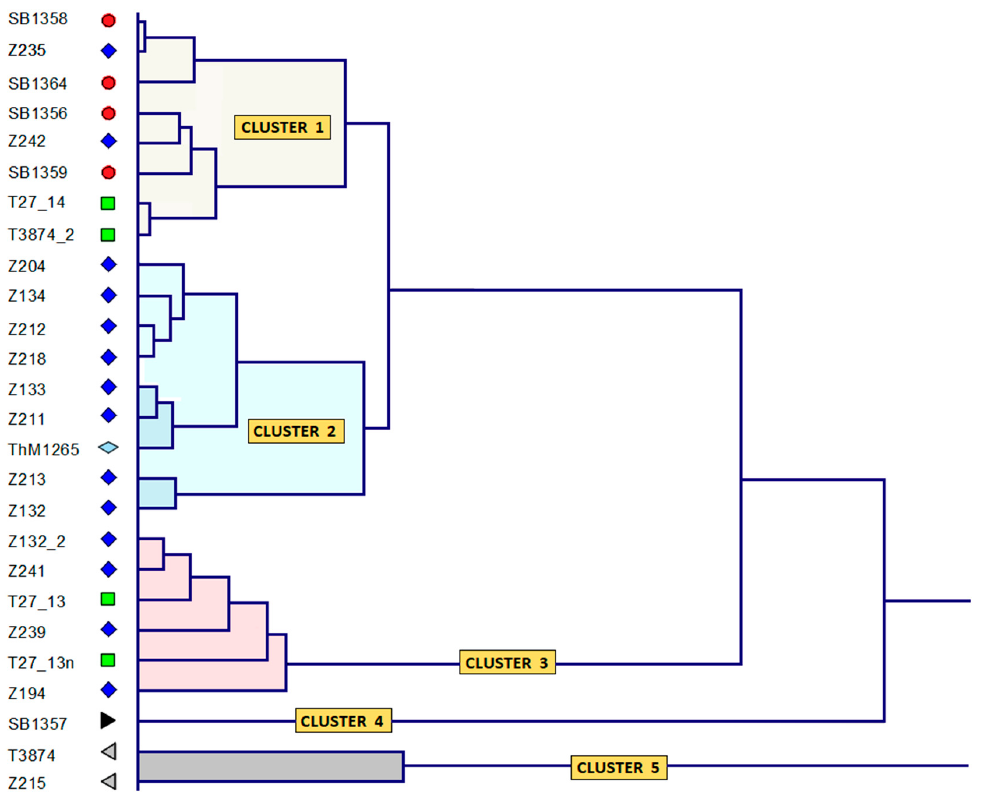
Figure 9. Dendrogram showing the clusters (Ward method) from the Andévalo samples (trans- formed data).